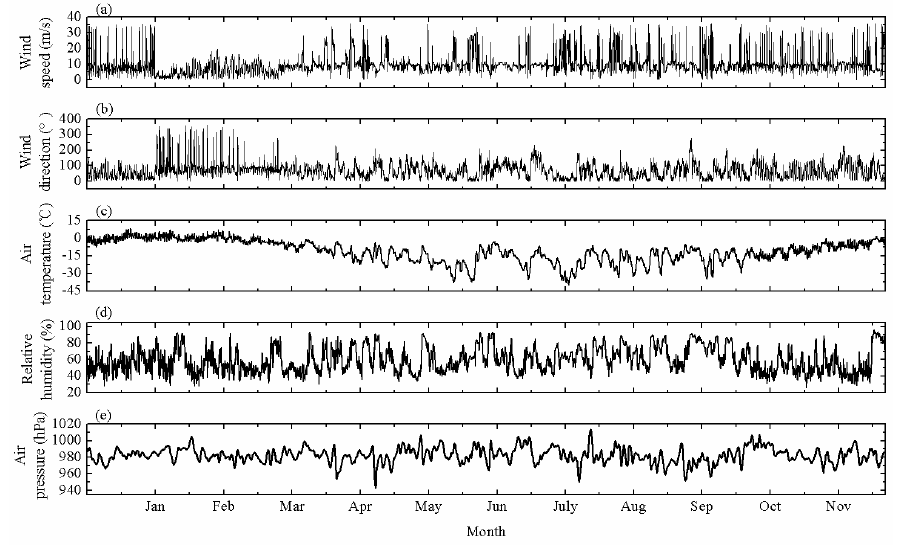
Figure 1. Time series of hourly ( a ) wind speed, ( b ) wind direction, ( c ) air temperature, ( d ) relative humidity and ( e ) air pressure obtained by the manned weather station at Zhongshan Station, Antarctica.